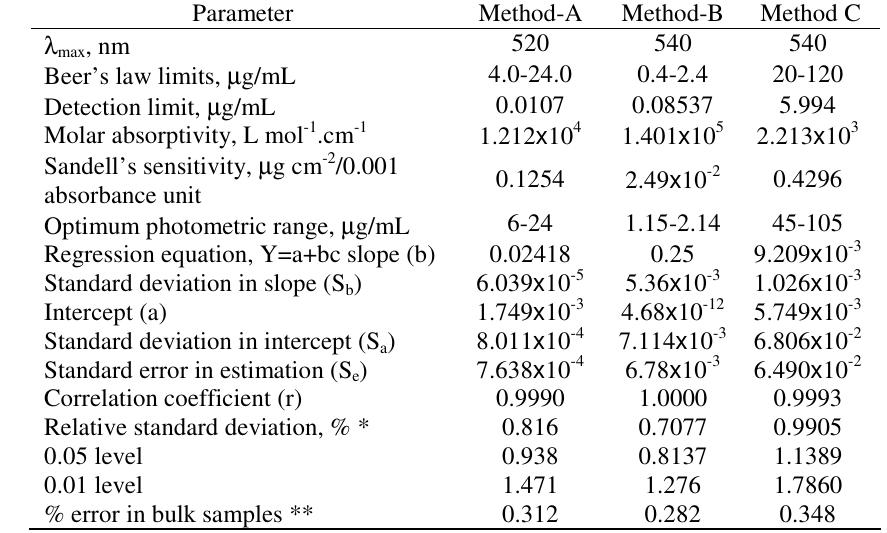
Table 1. Optical and regression characteristics, precision and accuracy of the proposed methods for CEFT.